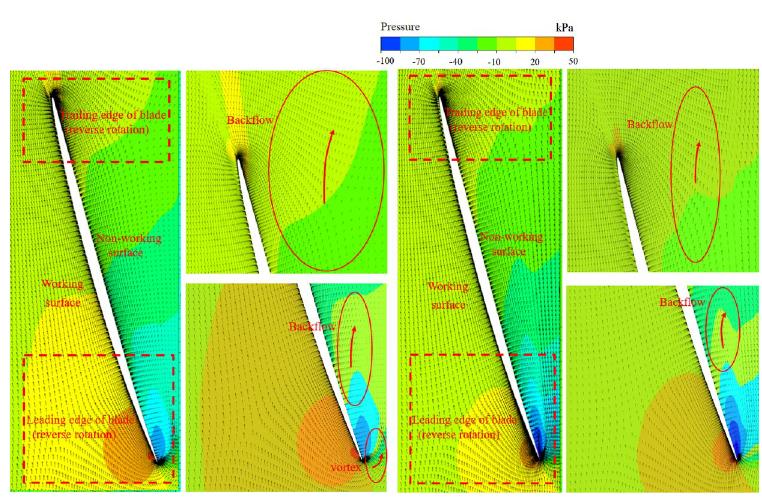
Figure 25. Pressure distribution and velocity vector diagram of 0.99 times the blade height in the pump section (span =